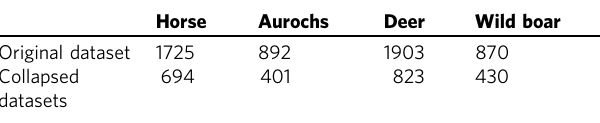
Table 1 Number of observations for each